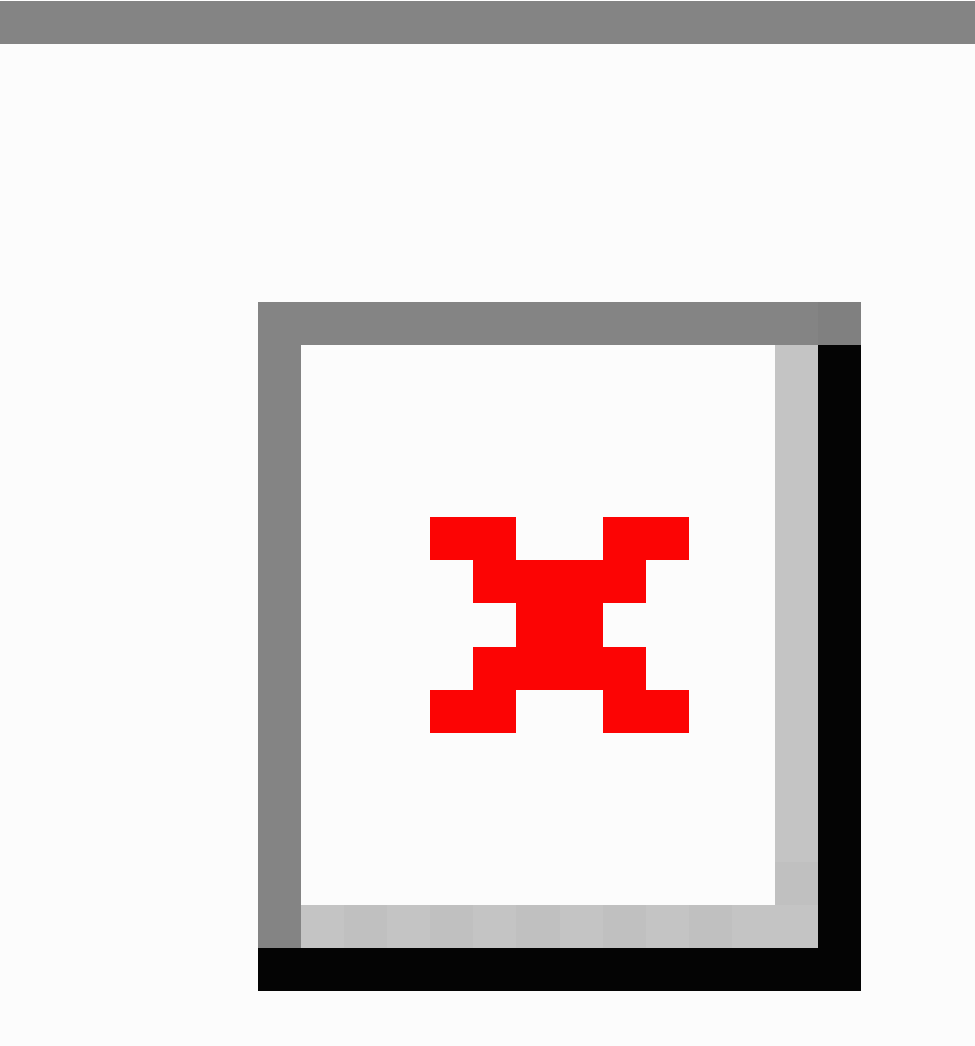
Figure 4. Managing Diabetes screenshot displaying problem-solving questions for glucose control